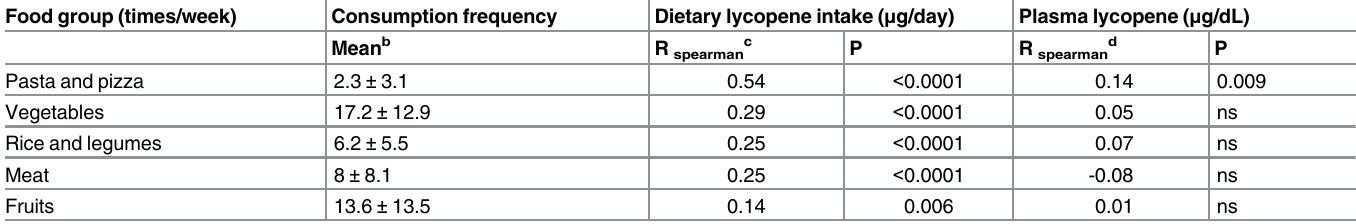
Table 4. Correlation a of food group consumption frequency with dietary lycopene intake and plasma lycopene concentrations (n = 369). Food group